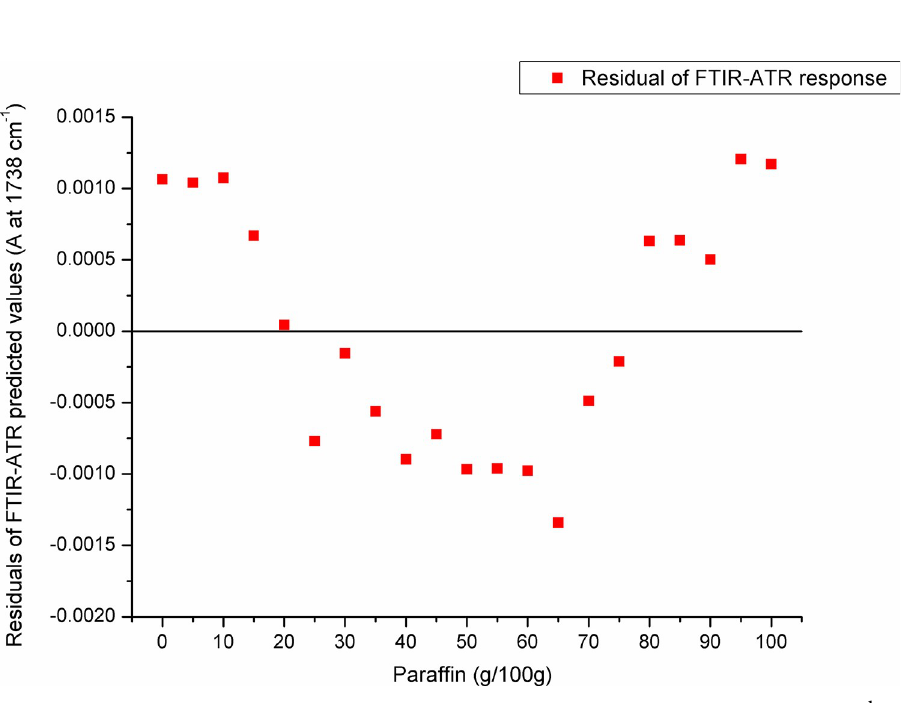
Fig 6. Residuals of FTIR-ATR prediction in the spectral region with an absorption maximum at 1738 cm -1 .